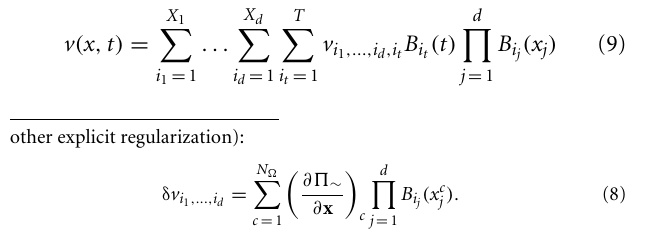
FIGURE 1 | Illustration of the greedy SyN formulation. Given images I A and I B , the symmetric set-up requires finding the two transform (cid:9) (cid:8) (cid:9) (cid:8) φ 2 , φ − 1 φ 1 , φ − 1 which map to/from the respective images to pairs 1 2 the midway point. During optimization, the update field at each